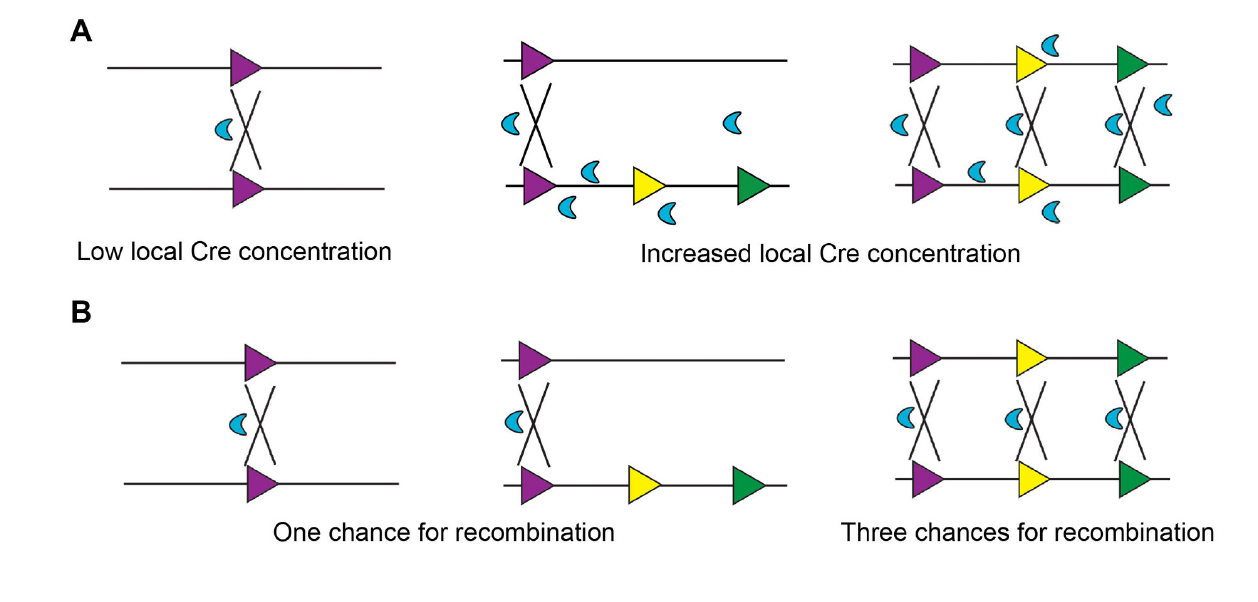
Figure 4. Two possible mechanisms for increased recombination efficiency of MADM-ML. (A) Hypothesis #1: increased recombination efficiency could result from higher local Cre recombinase concentration retained by multiple loxP sites. If this is the case, then ML/SL should have an intermediate recombination efficiency between SL/SL and ML/ML. (B) Hypothesis #2: increased recombination efficiency could be due to increased substrate concentration, i.e. three times more loxP site pairing. If this is the case, then ML/SL should have the same recombination efficiency as SL/SL